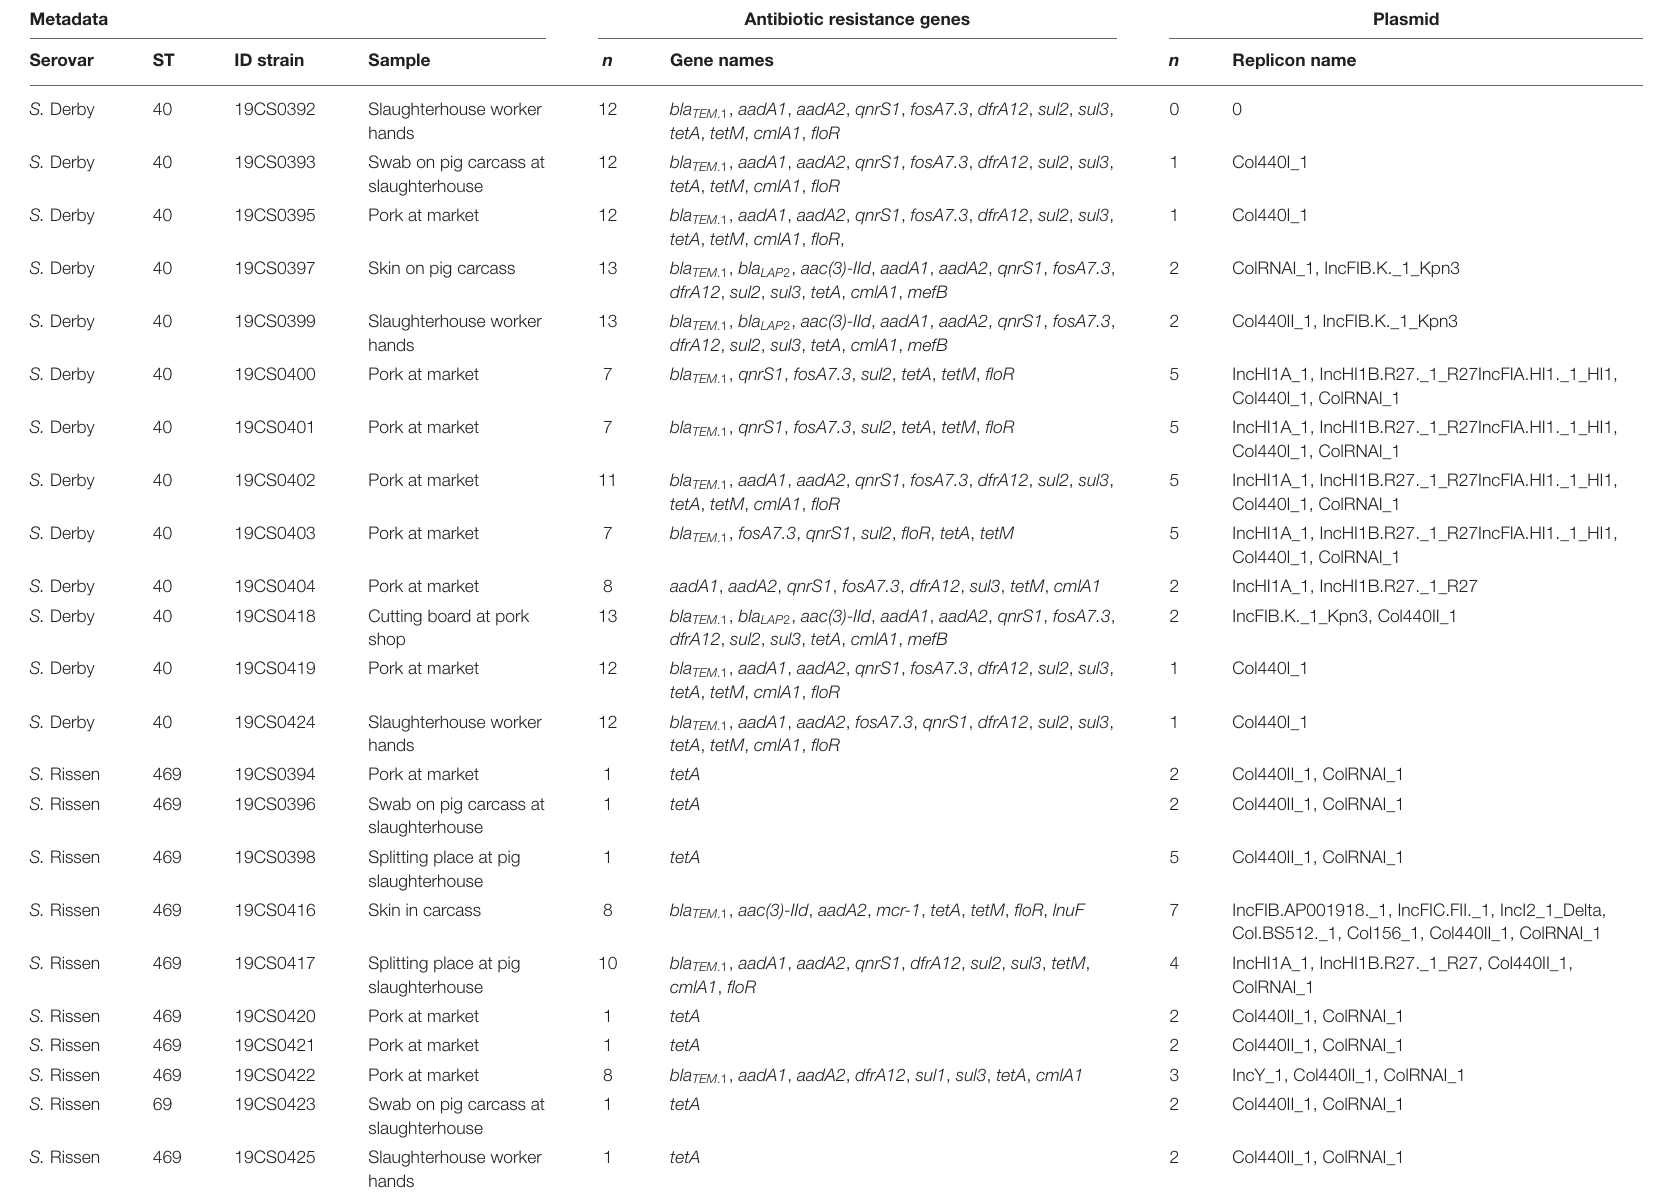
TABLE 1 | Bioinformatics results of the 23 isolates of Salmonella enterica subsp. enterica serovar Derby and Rissen.